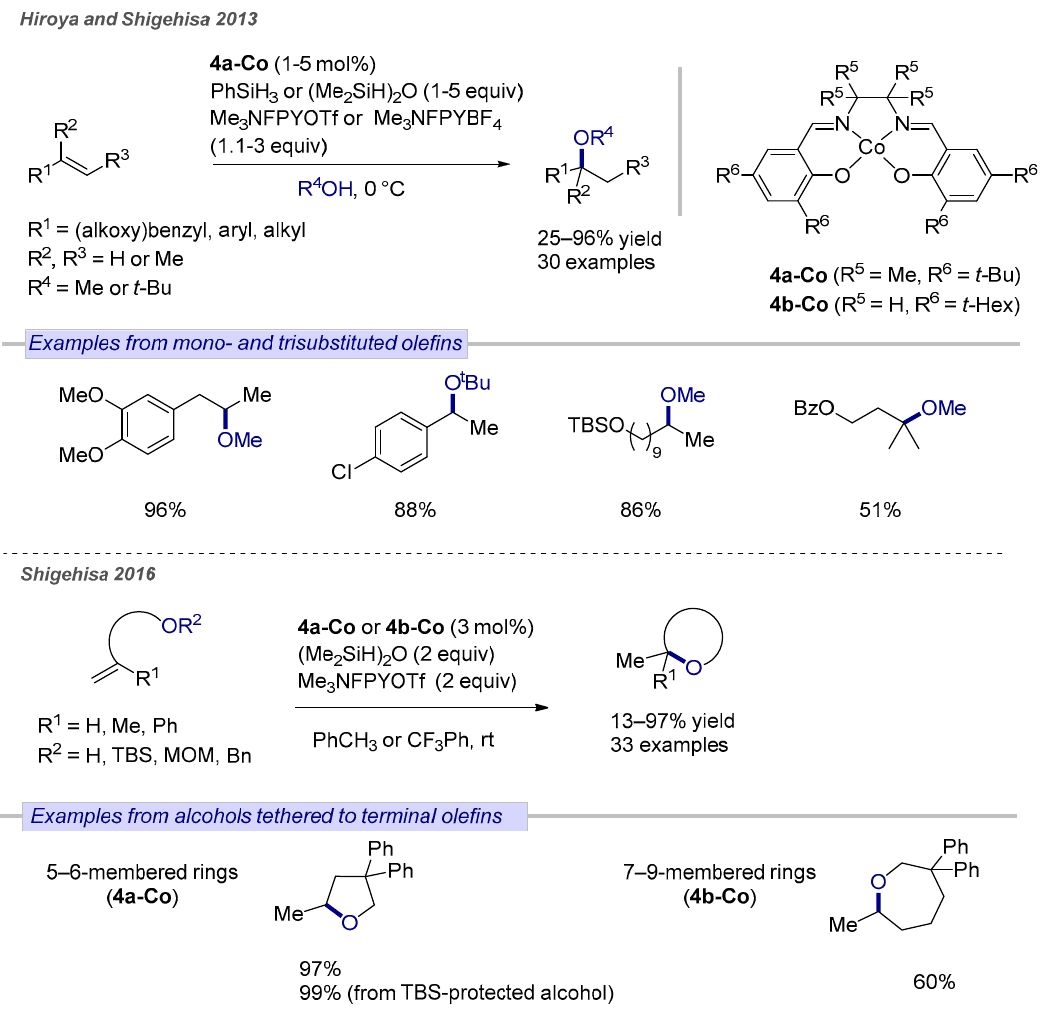
that the cobalt should interfere within the C–O bond-forming transition state involving a cationic Co complex [84].